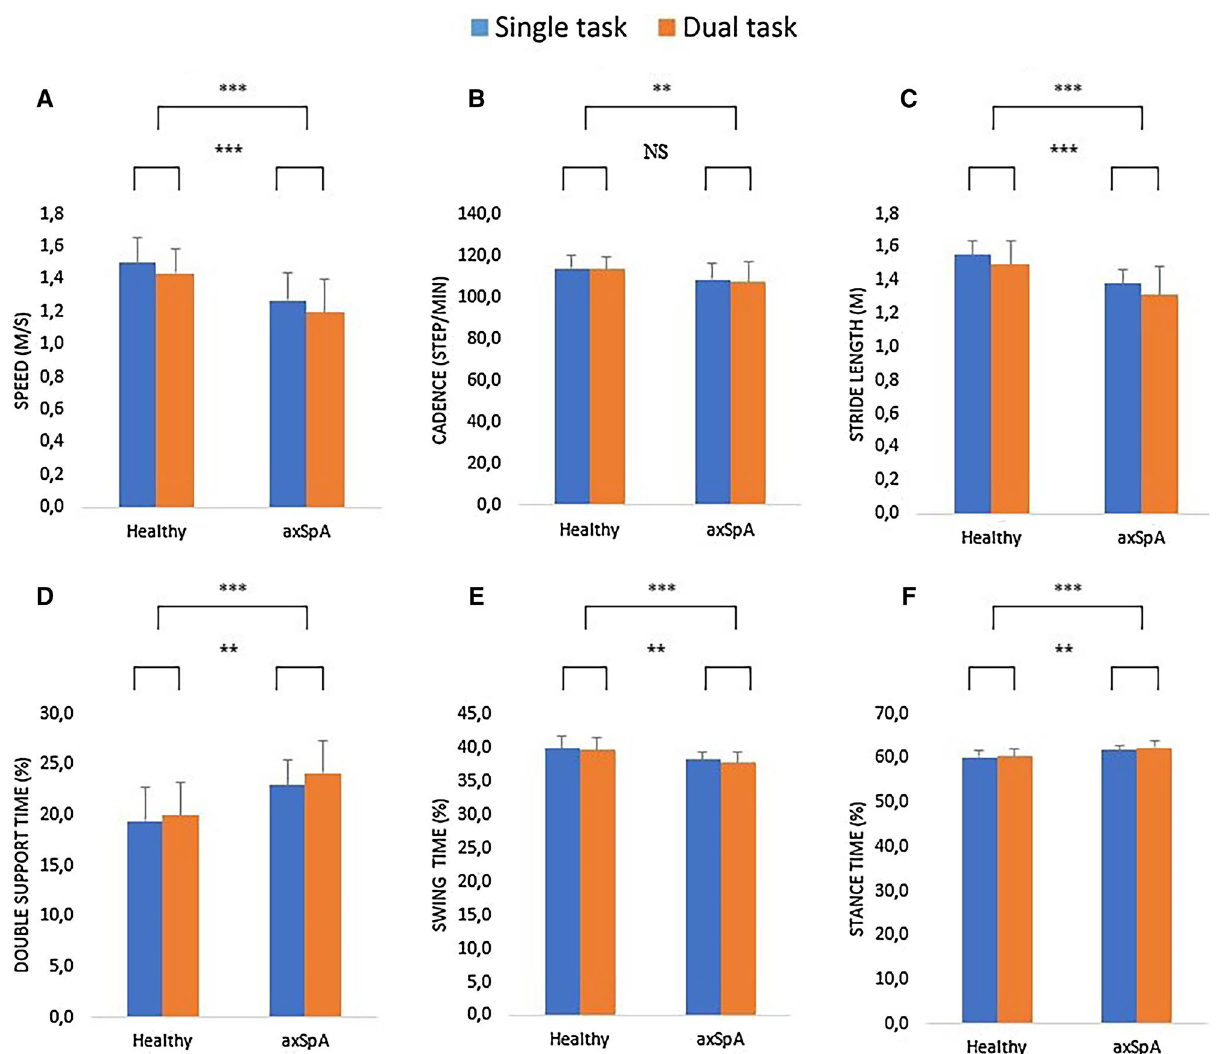
Figure 2. Mean and standard deviation of the spatiotemporal gait parameters obtained in healthy controls and patients with axSpA in single- and dual-task conditions ( A gait speed, B cadence, C stride length, D double support time, E swing time, F stance time) (** p < 0.01, *** p < 0.001, NS non